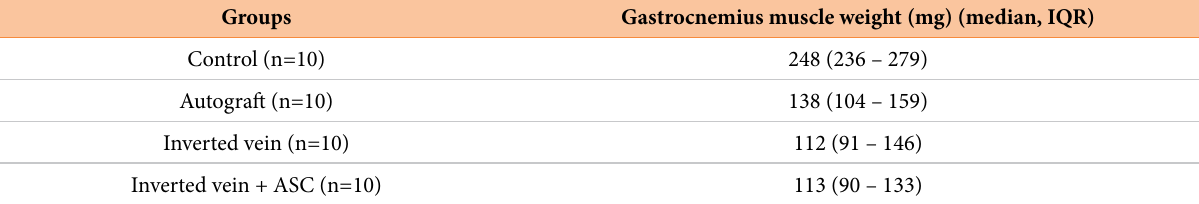
Table 2 - Gastrocnemius muscle weight for each group and respective contralateral sides (control nerve group).